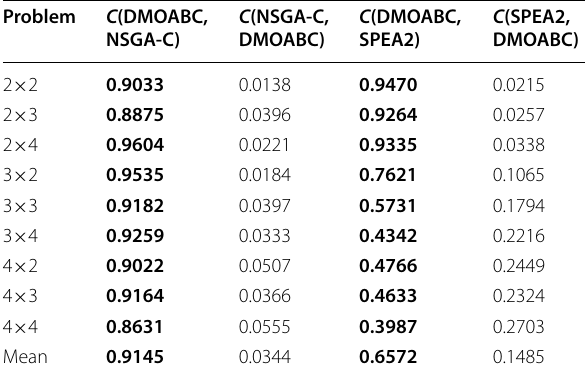
Table 6 C -metric comparison for DMOABC, NSGA-II, and SPEA2 Problem